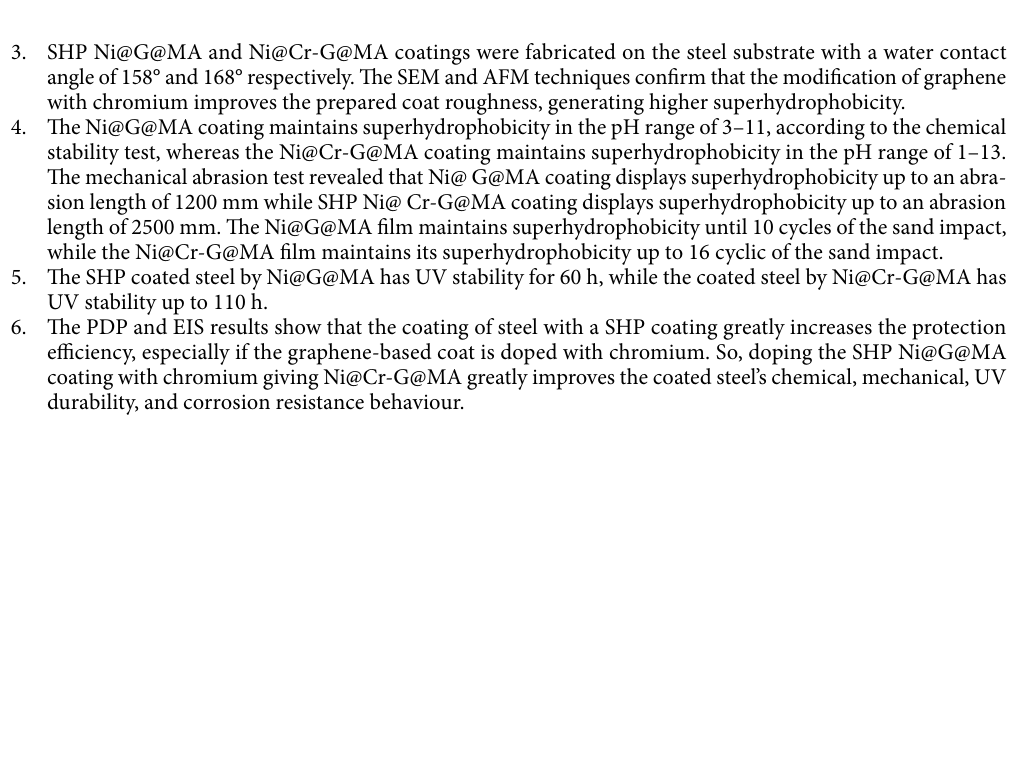
Table 2. The PDP parameters for the bare and the SHP coated steel in 0.5 M NaCl solution.